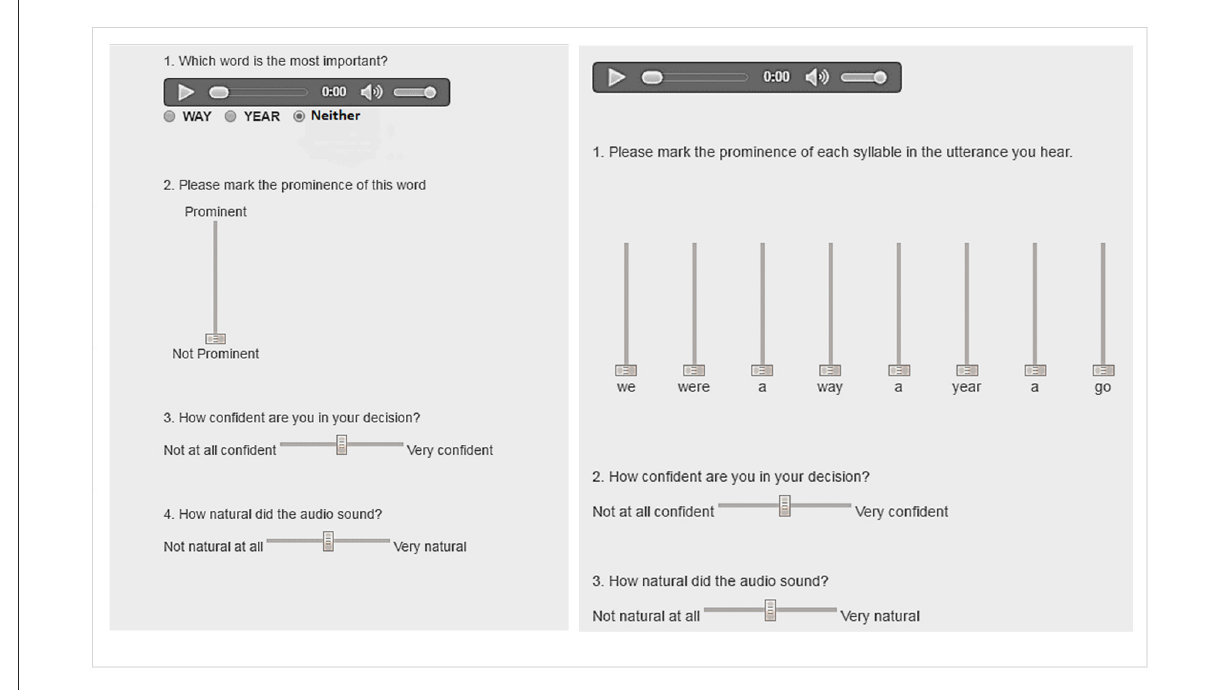
FIGURE3 Experimental interface for Test 1 (left panel) and Test 2 (right panel)